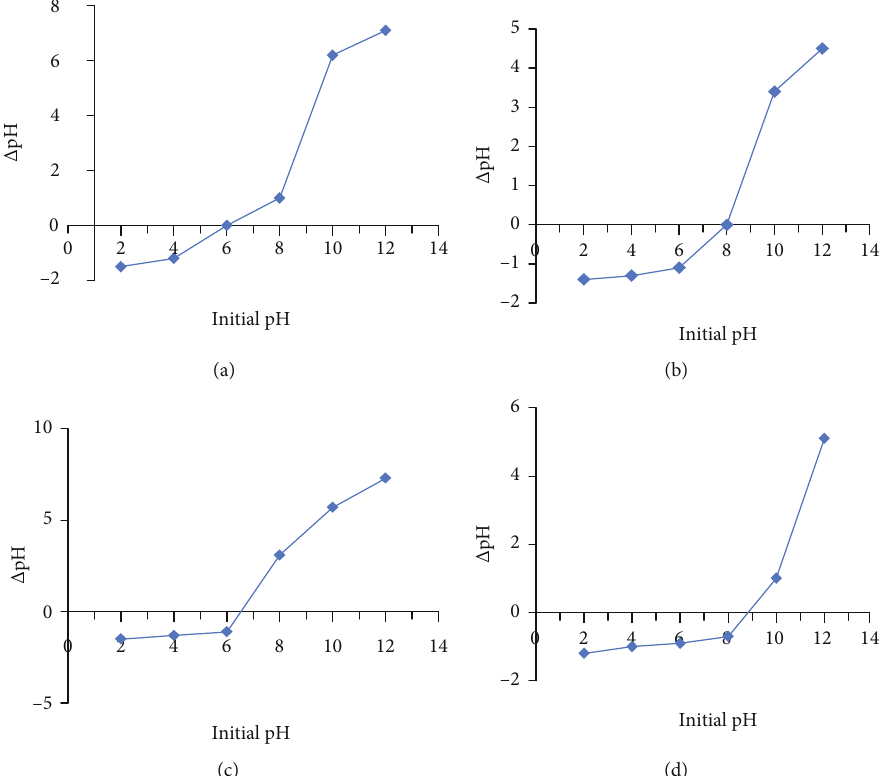
Figure 2: pH at point of zero charge for TAADFPs activated at (a) 450 ° C, (b) 500 ° C, (c) 550 ° C, and (d) 600 ° C.